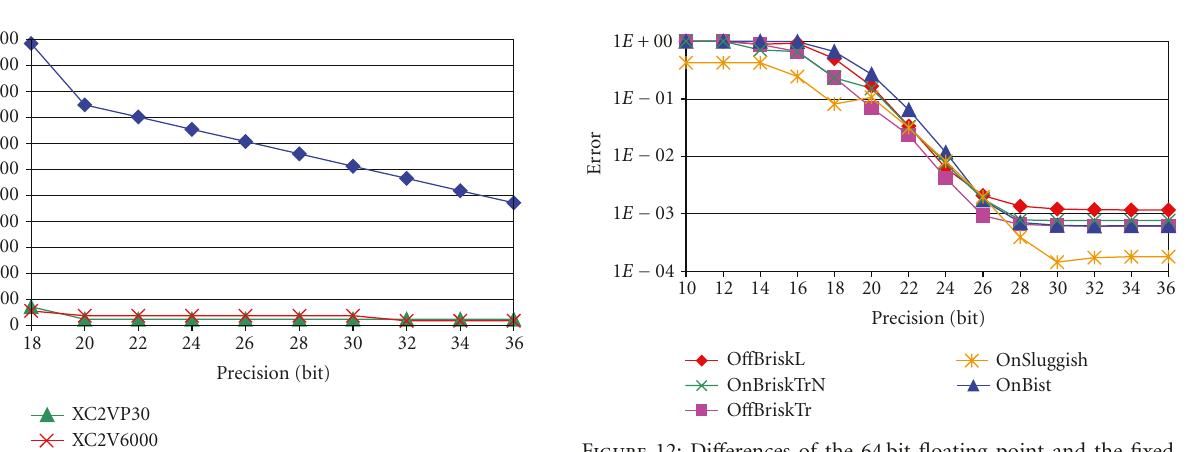
Figure 12: Di ff erences of the 64bit floating-point and the fixed- point result of the various retina